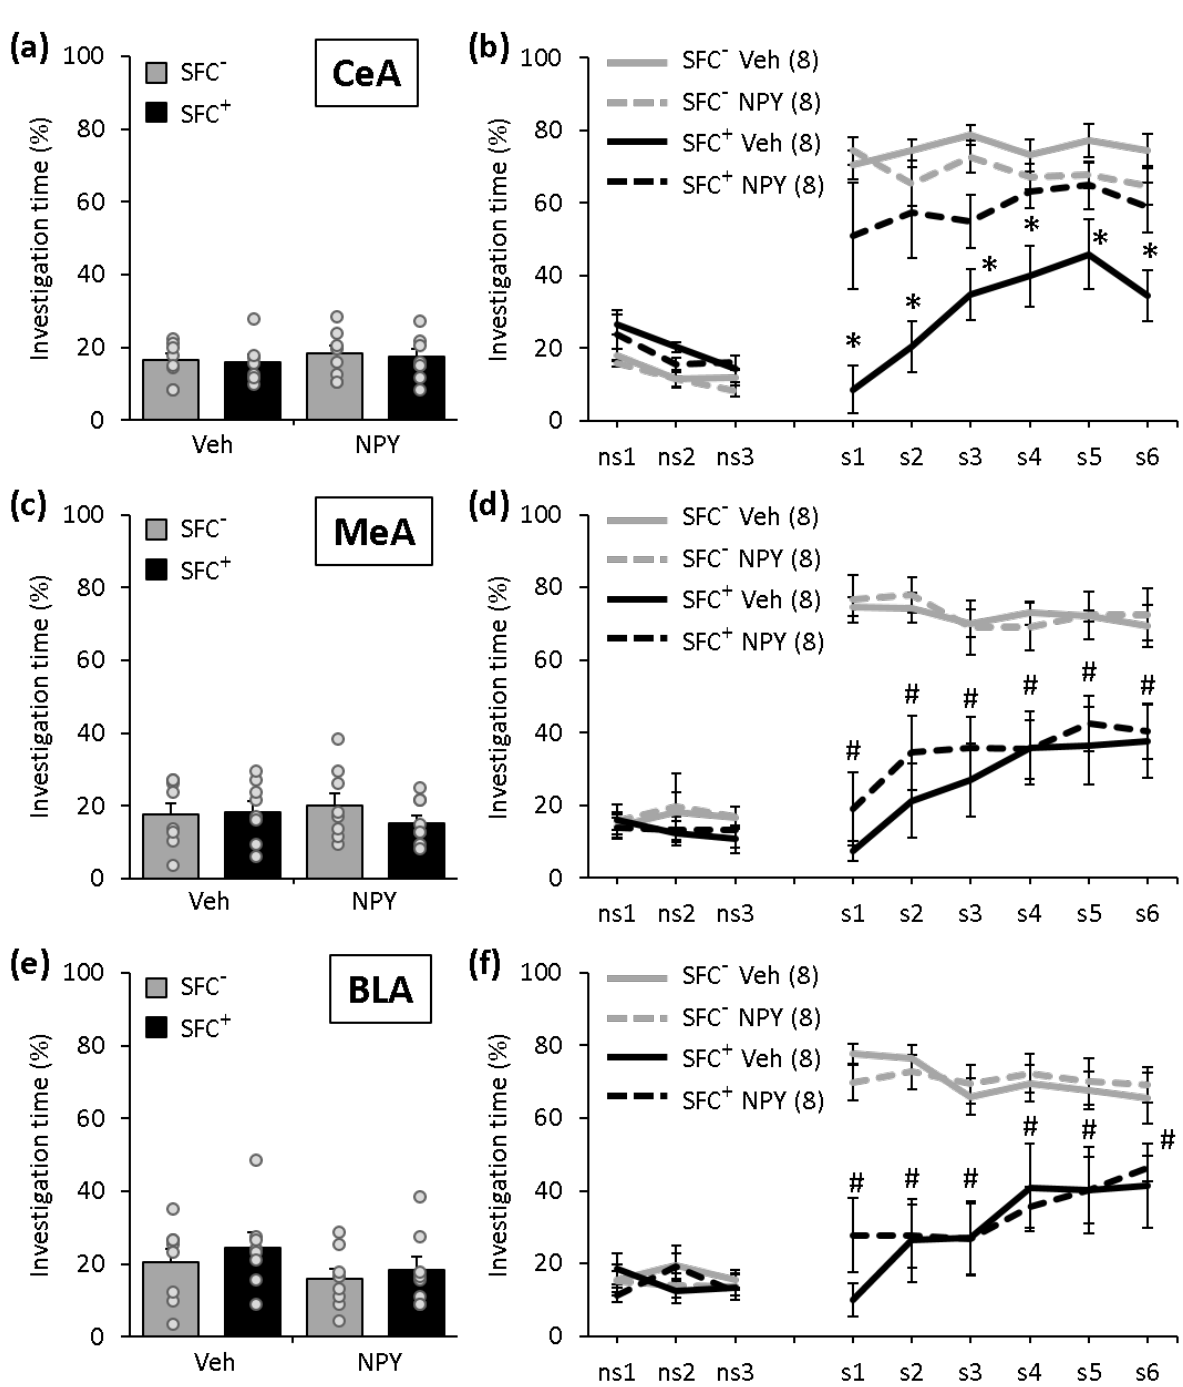
Figure 3. NPY reduces the expression of social fear when administered into the central amygdala (CeA), but not when administered into the medial (MeA) or basolateral amygdala (BLA). ( a , c , e ) Pre-conditioning investigation of the non-social stimulus (empty cage) during SFC on day 1. ( b , d , f ) Investigation of the non-social (ns1–ns3) and social (cages with mice; s1–s6) stimuli during social fear extinction on day 2. Unconditioned (SFC − ) and conditioned (SFC + ) mice were administered either vehicle (Veh; 0.2 µ L/side) or NPY (0.1 nmol/0.2 µ L/side) 10 min before social fear extinction. Data represent means ± SEM and numbers in parentheses indicate group sizes. p < 0.05 * vs. all groups; # vs. respective SFC − controls.